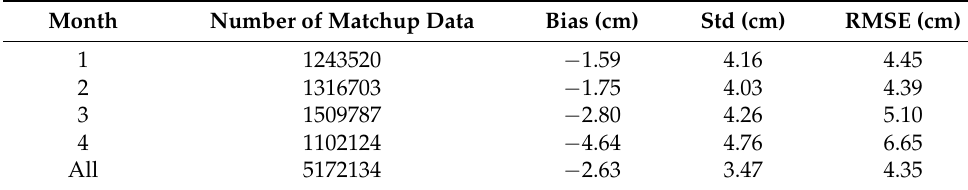
Table 7. Statistics of snow depth differences (RSD minus AMSR-E).